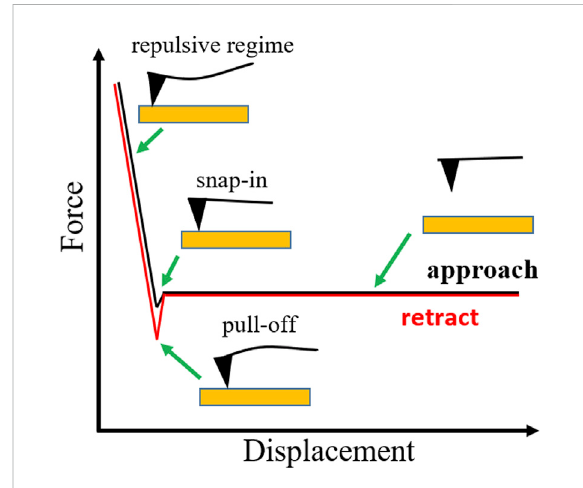
FIGURE 1 Schematic of a force-displacement graph during an AFM force measurement with the characteristic points “ snap-in ” and “ pull-off ” , the force value at the pull off point corresponds to the adhesion